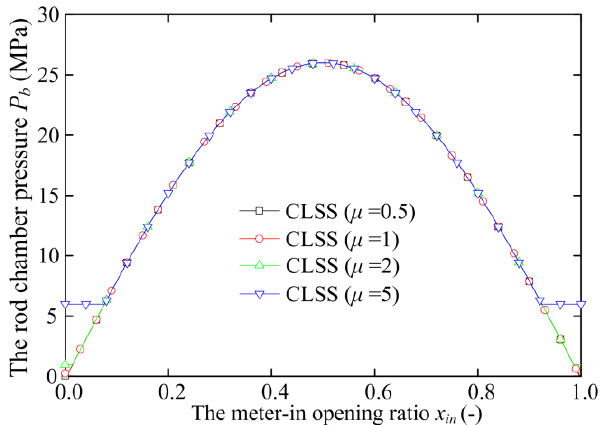
Figure 14. The rod chamber pressure P b of CLSS with extension working mode.